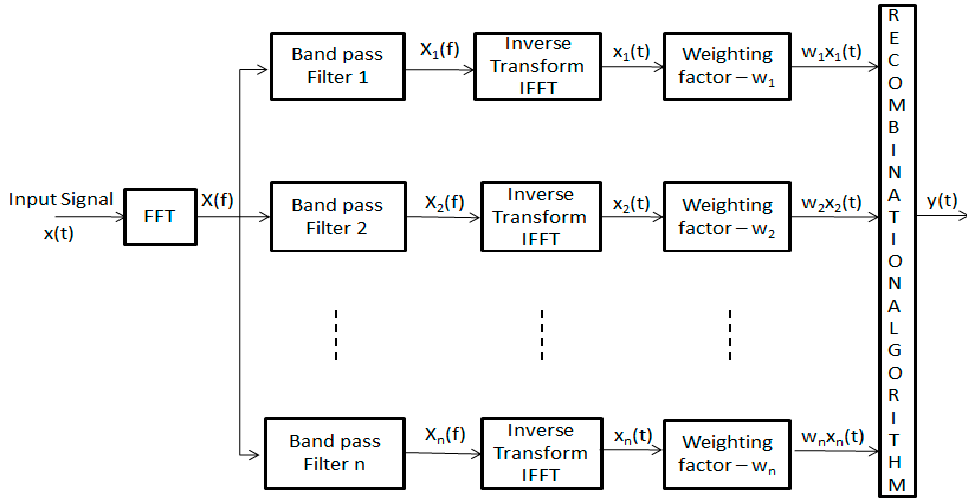
Figure 2. Split-signal processing (SSP) block diagram.